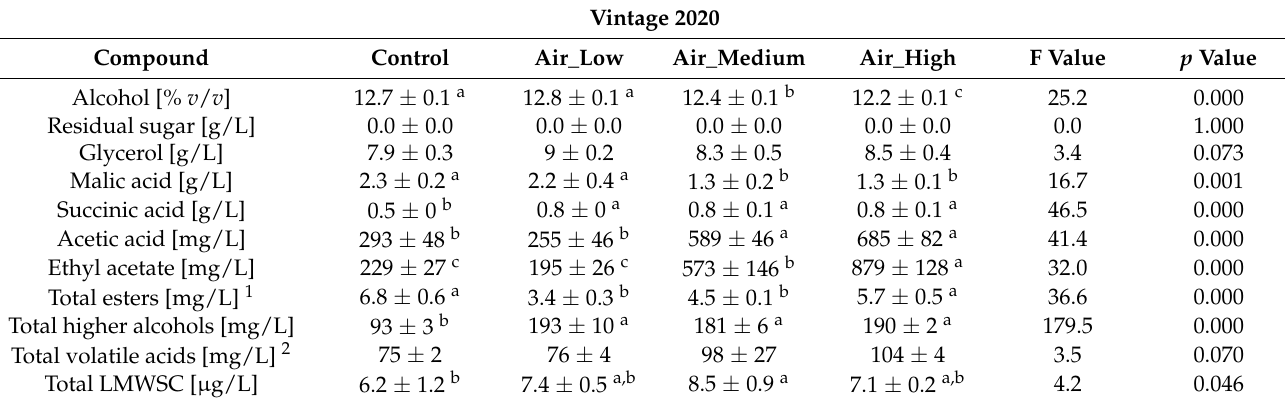
Table 2. Post-fermentation chemical composition for vintage 2020